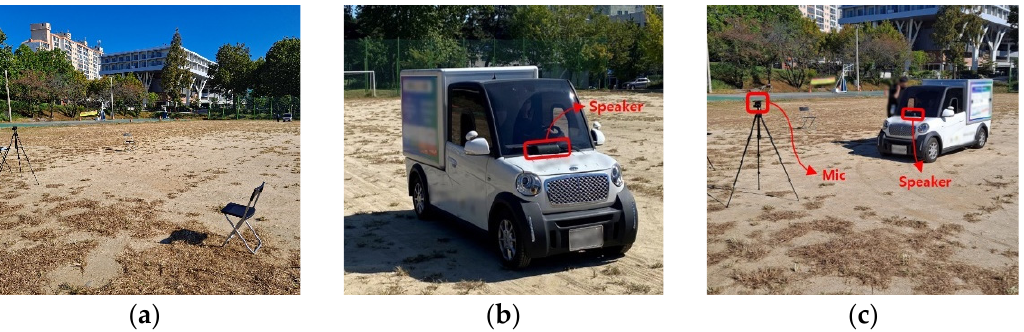
Figure 4. Data Collection Environment (Outdoor Experiment): ( a ) Sensor Setup, ( b ) Moving Vehicle and Speaker Installation, ( c ) Data Collection Process.